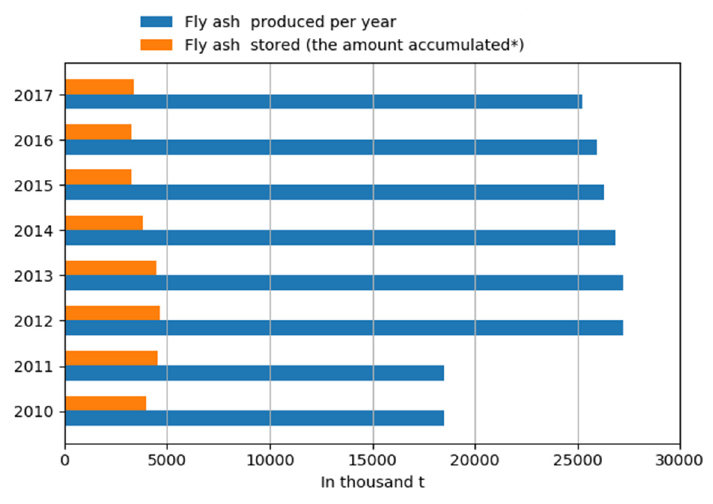
Figure 1. Graph of quantities of fly ash (FA) produced and deposited on landfills in Poland in 2010–